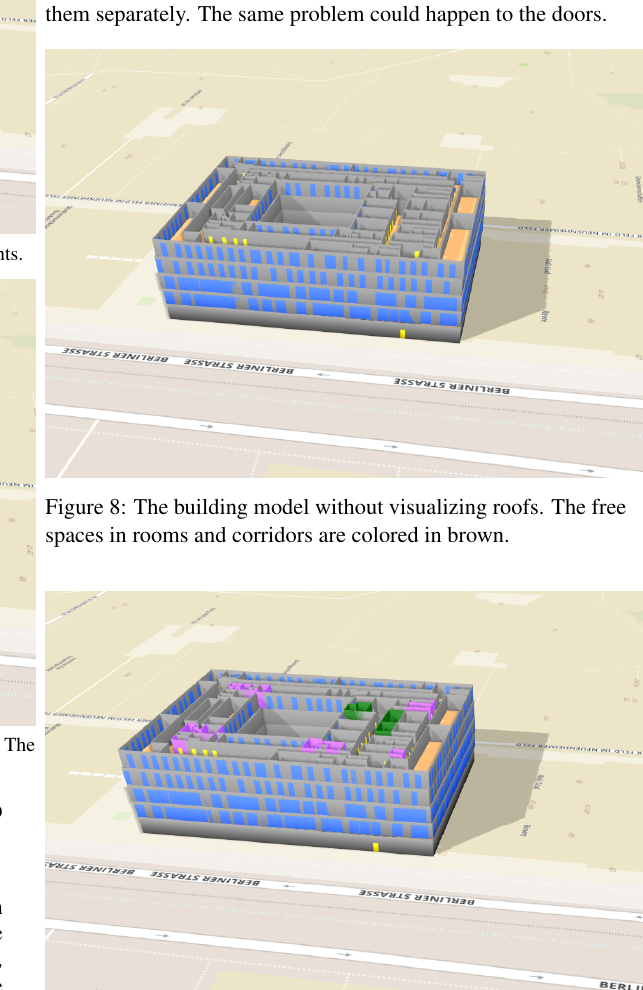
Figure 9: The building model with highlighted rooms. The rooms colored in purple are toilets. The rooms colored in green are meeting